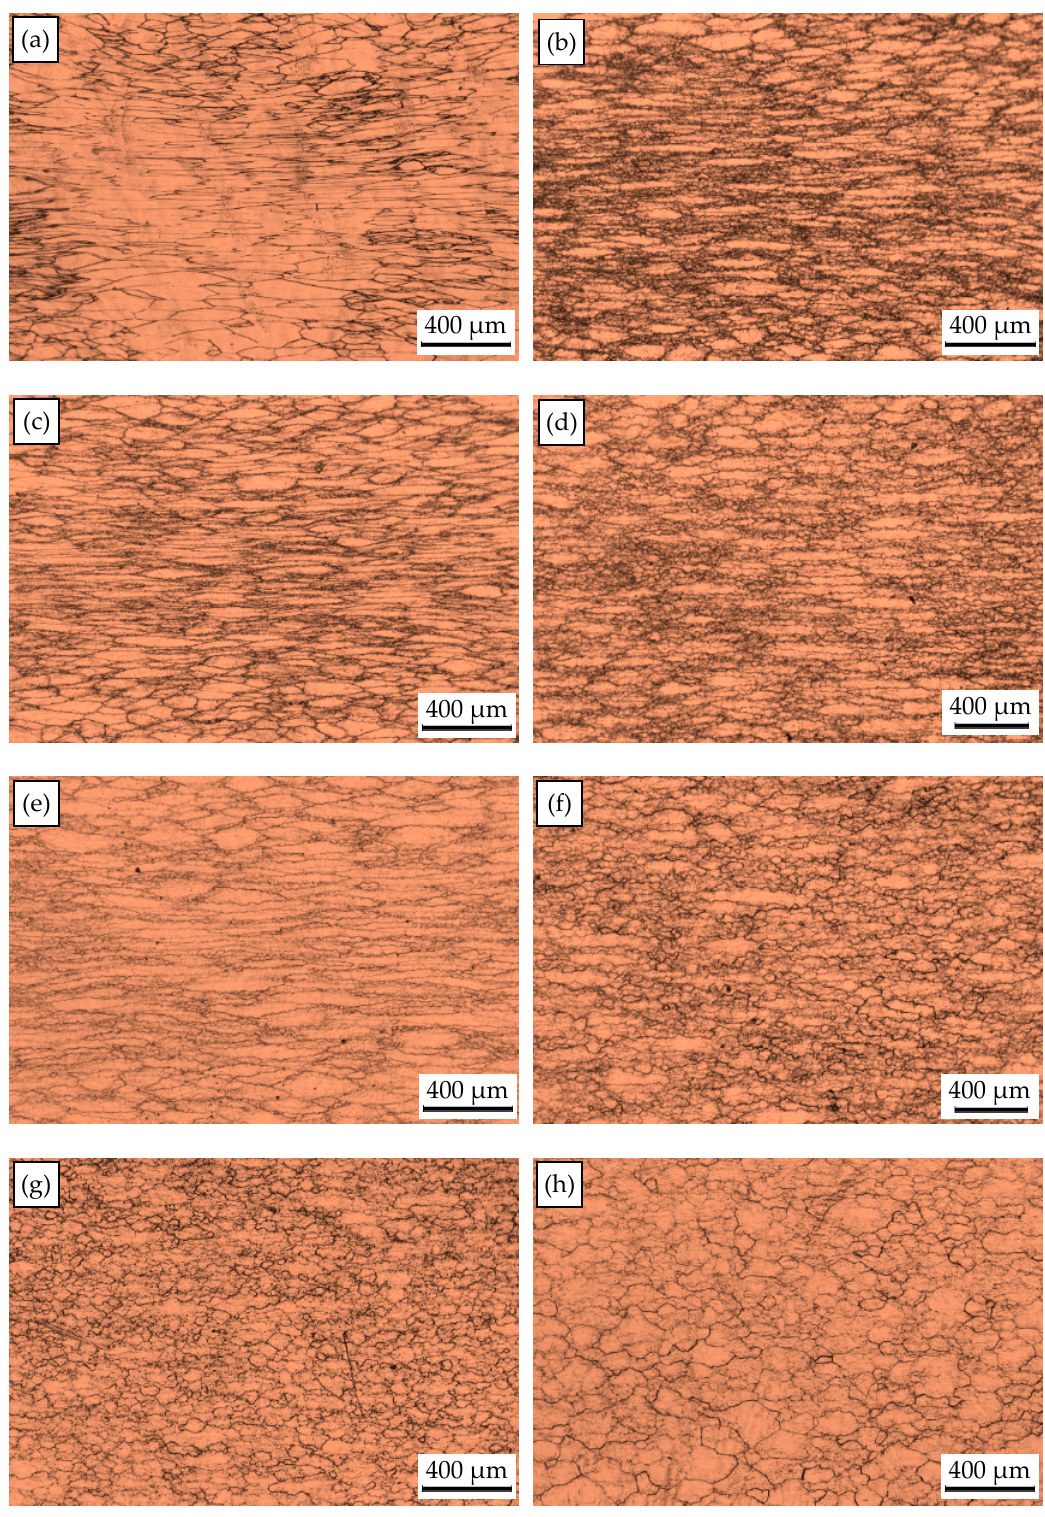
Figure 3. Optical microstructures of the deformed samples at a strain of 0.8 and deformation conditions of ( a ) 850 ◦ C / 1 s − 1 , ( b ) 850 ◦ C / 0.01 s − 1 , ( c ) 900 ◦ C / 0.1 s − 1 , ( d ) 950 ◦ C / 0.01 s − 1 , ( e ) 1000 ◦ C / 0.1 s − 1 , ( f ) 1000 ◦ C / 0.01 s − 1 , ( g ) 900 ◦ C / 0.001 s − 1 and ( h ) 1000 ◦ C / 0.001 s − 1 .